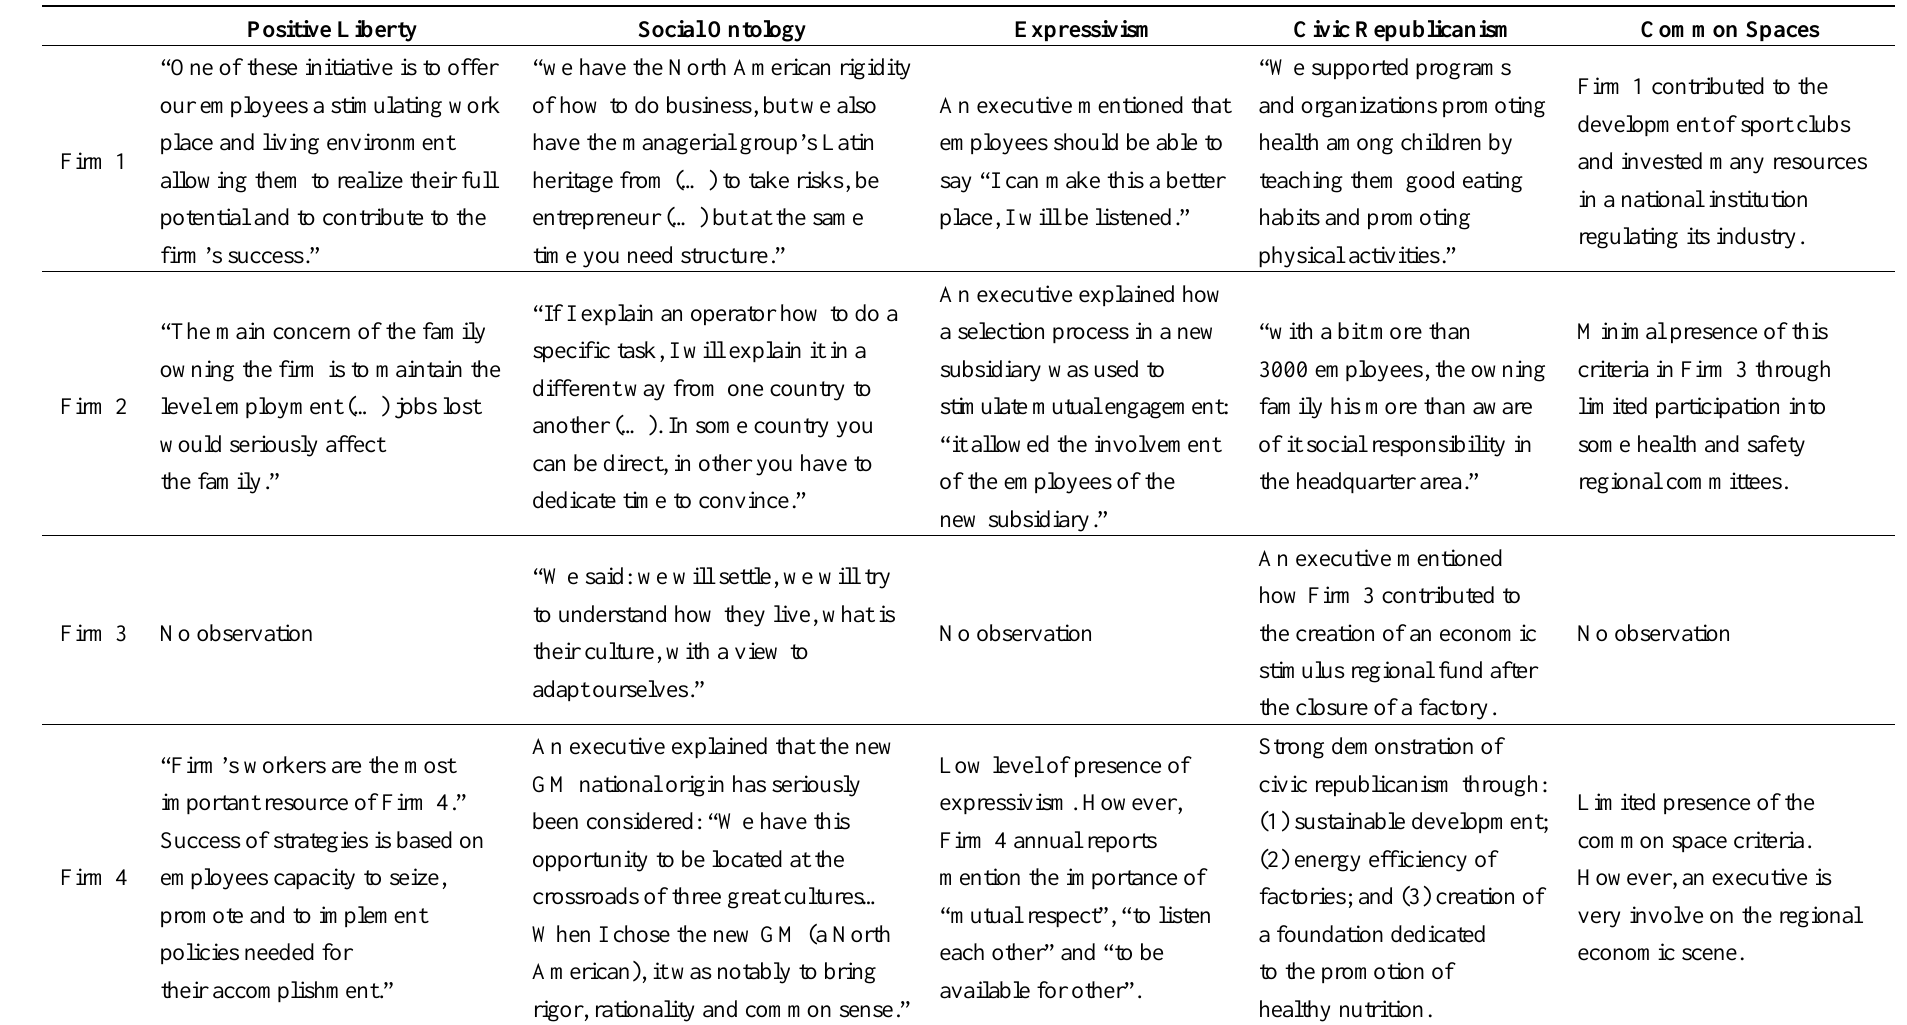
Table 3. Evidence of Taylorian criteria, by